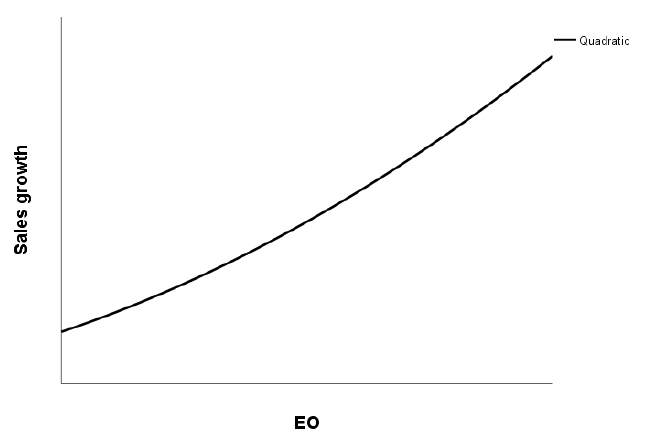
Figure 2. Nonlinear effect of EO on sales growth.